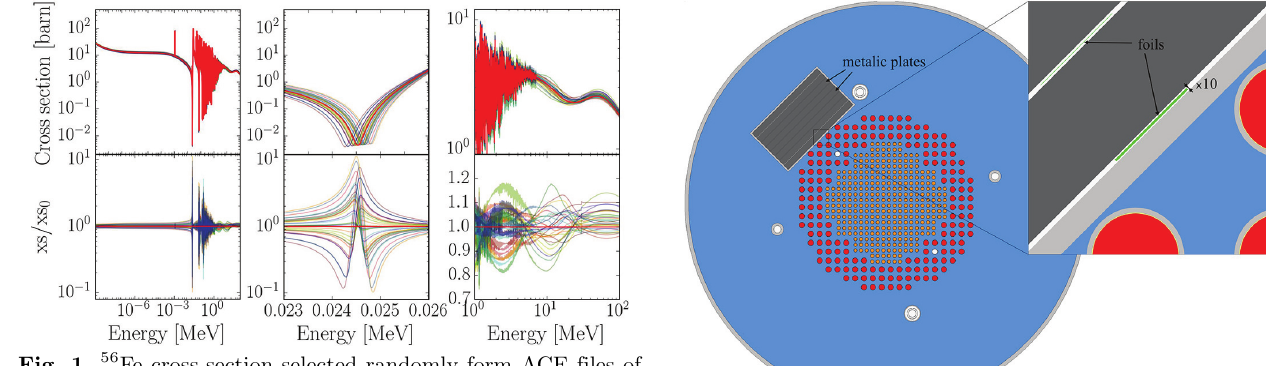
Fig. 1. 56 Fe cross-section selected randomly form ACE files of the TENDL2017 nuclear database (left) with a zoom on the first resonance (middle) and in the high energy (right) regions. The first ACE file (in red in the upper row) has been used as reference and the variation between this file and 32 versions of this cross section is displayed in the lower row.